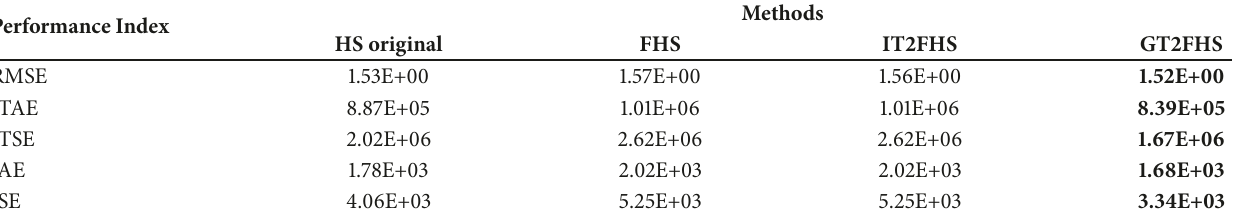
Table 6: Simulation results without perturbation in the controller.